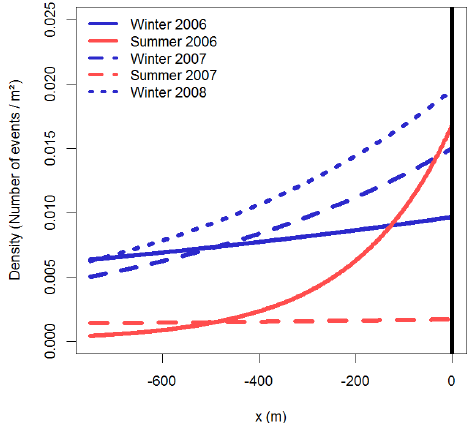
Figure 7. Evolution of the spatial density (number of events per unit area) alongshore ( x coordinate) modelled by Eq. (6) for the large volumes considering the different measurement epochs. Note the position of the groyne at x =